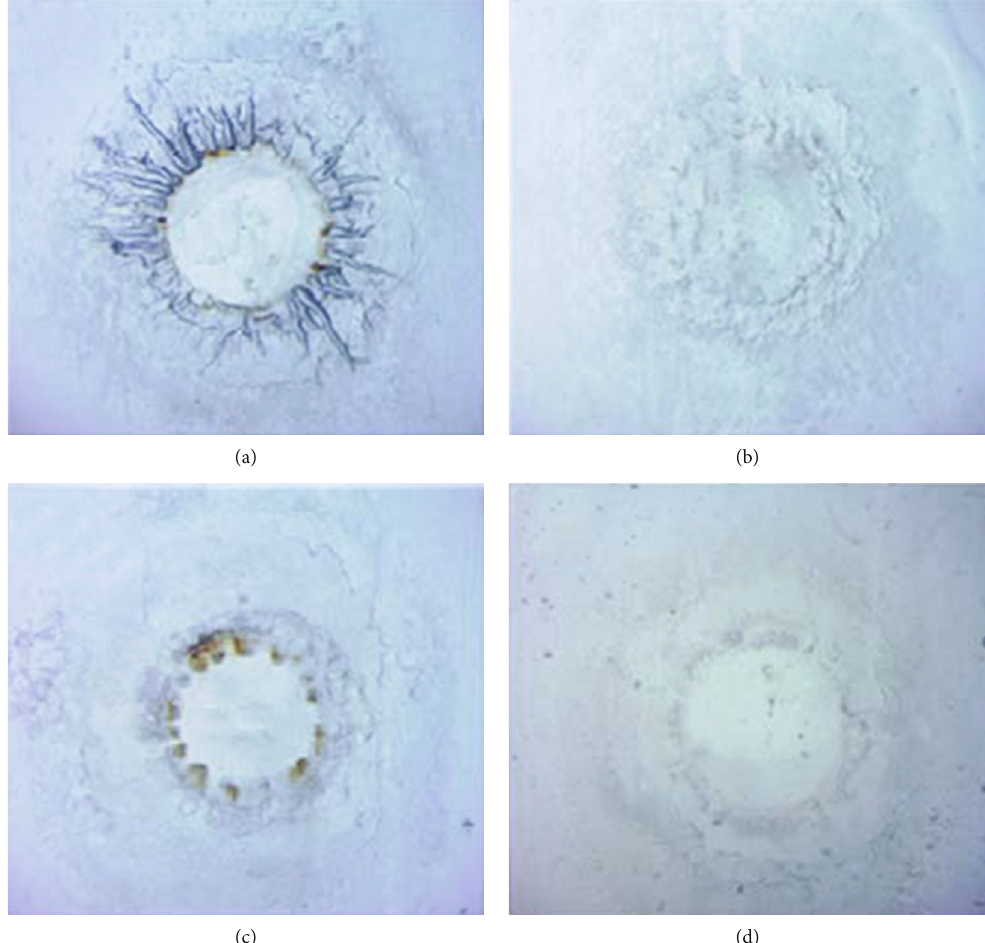
Figure 8: Surface erosion morphology by PD for epoxy nanocomposites with di ff erent alkyl-modi fi ed nanosilica contents: (a) 0phr, (b) 1phr, (c) 3phr, and (d) 5phr.